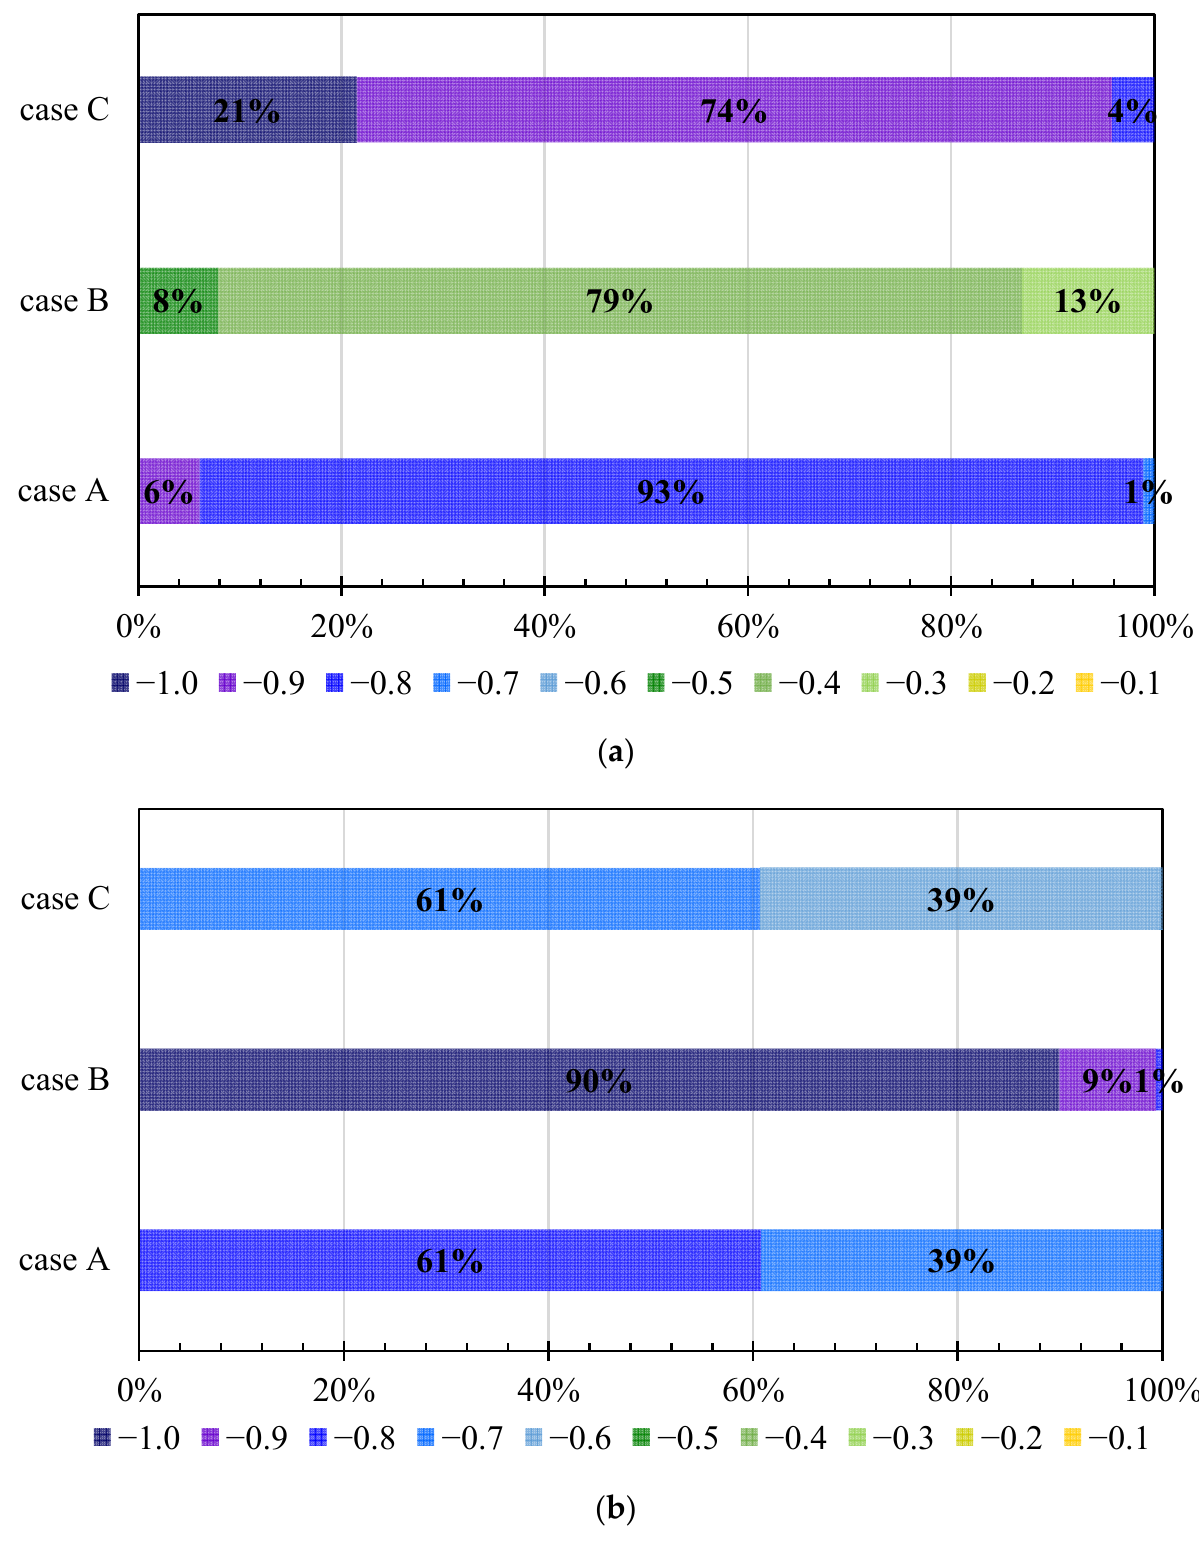
Figure 12. Inter-case comparison of heat distribution ratios in winter: ( a ) first-floor residential domain PMV presence ratio; ( b ) PMV occurrence rate on the second floor. The results show that Case B was the most neutral for the first floor while Case C showed a large PMV value ratio of − 1.0 (-) (21%). In other words, the environment was